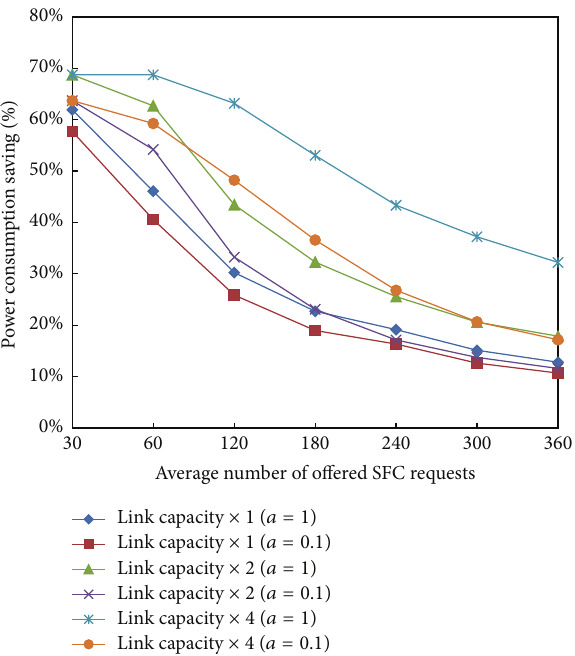
Figure10:Thepowerconsumptionpercentagesavingachievedwith the application of the consolidation technique versus the average number of SFCs offered in the PHI. The cases 𝑎 = 1 and 𝑎 = 0.1 are